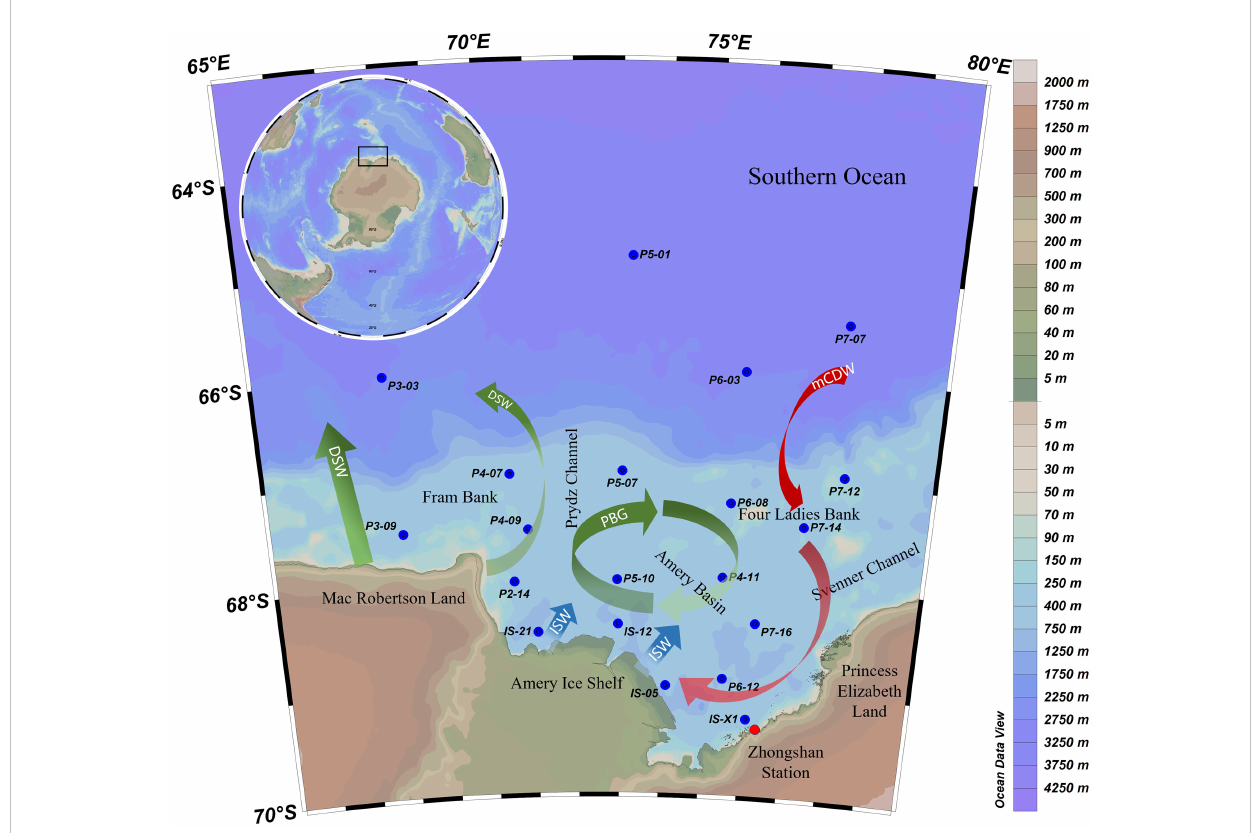
FIGURE 1 Surface sediment sampling stations in Prydz Bay and the adjacent Southern Ocean during the 24 th to 29 th Chinese National Antarctic Research Expeditions (CHINARE-24 to -29). The circum fl uence map is modi fi ed after Williams et al. (2016). PBG, Prydz Bay Gyre; mCDW, modi fi ed Circumpolar Deep Water; DSW, Dense Shelf Water; ISW, Ice Shelf Water.